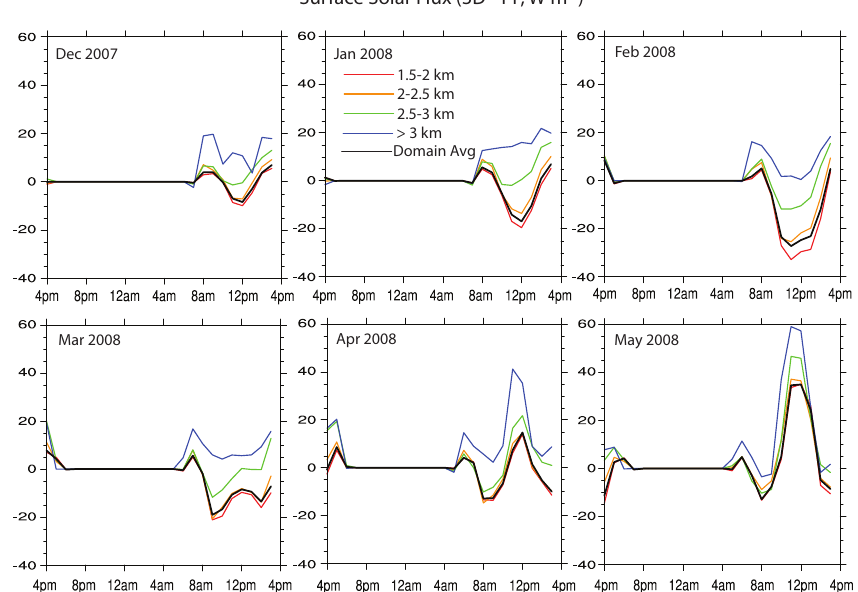
Fig. 5. Deviations (3-D-PP) in the monthly mean domain-averaged diurnal variation time series of surface solar flux for a number of elevation ranges, including 1.5–2km (red), 2–2.5km (orange), 2.5–3m (green), above 3km (blue), as well as the whole domain (black), over the Rocky Mountains–Sierra Nevada area for 6 months (December 2007 to May 2008). Flat lines denote nighttime, during which solar insolation is zero.